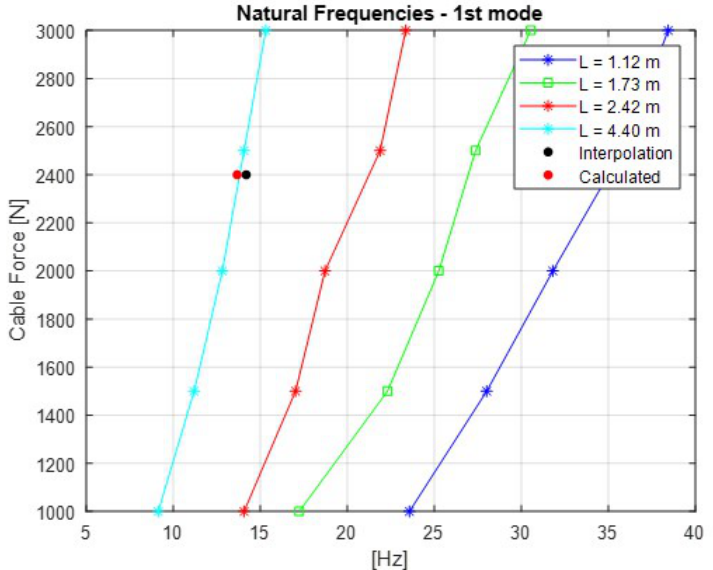
Figure 7. Relationship between the cable force and natural frequencies for the first mode of